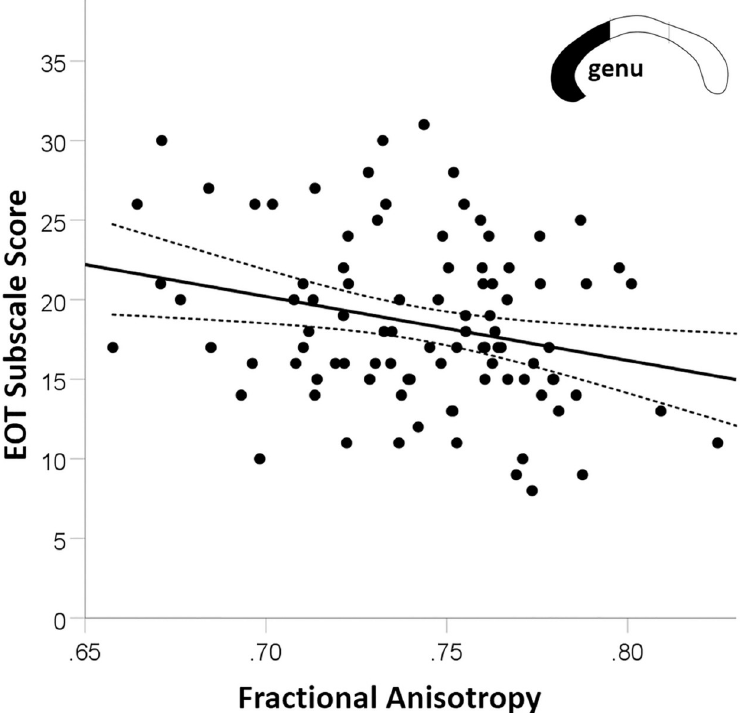
Fig 4. Association of EOT and genu FA. A significant negative correlation ( r = -.259, p = .012) between FA in the genu and EOT in the male sample, was found to be the main factor underlying a significant three-way interaction of EOT, subregion, and sex. For no further callosal parameter, subregion, or subscale comparable effects were found. Details are presented in the Results section.